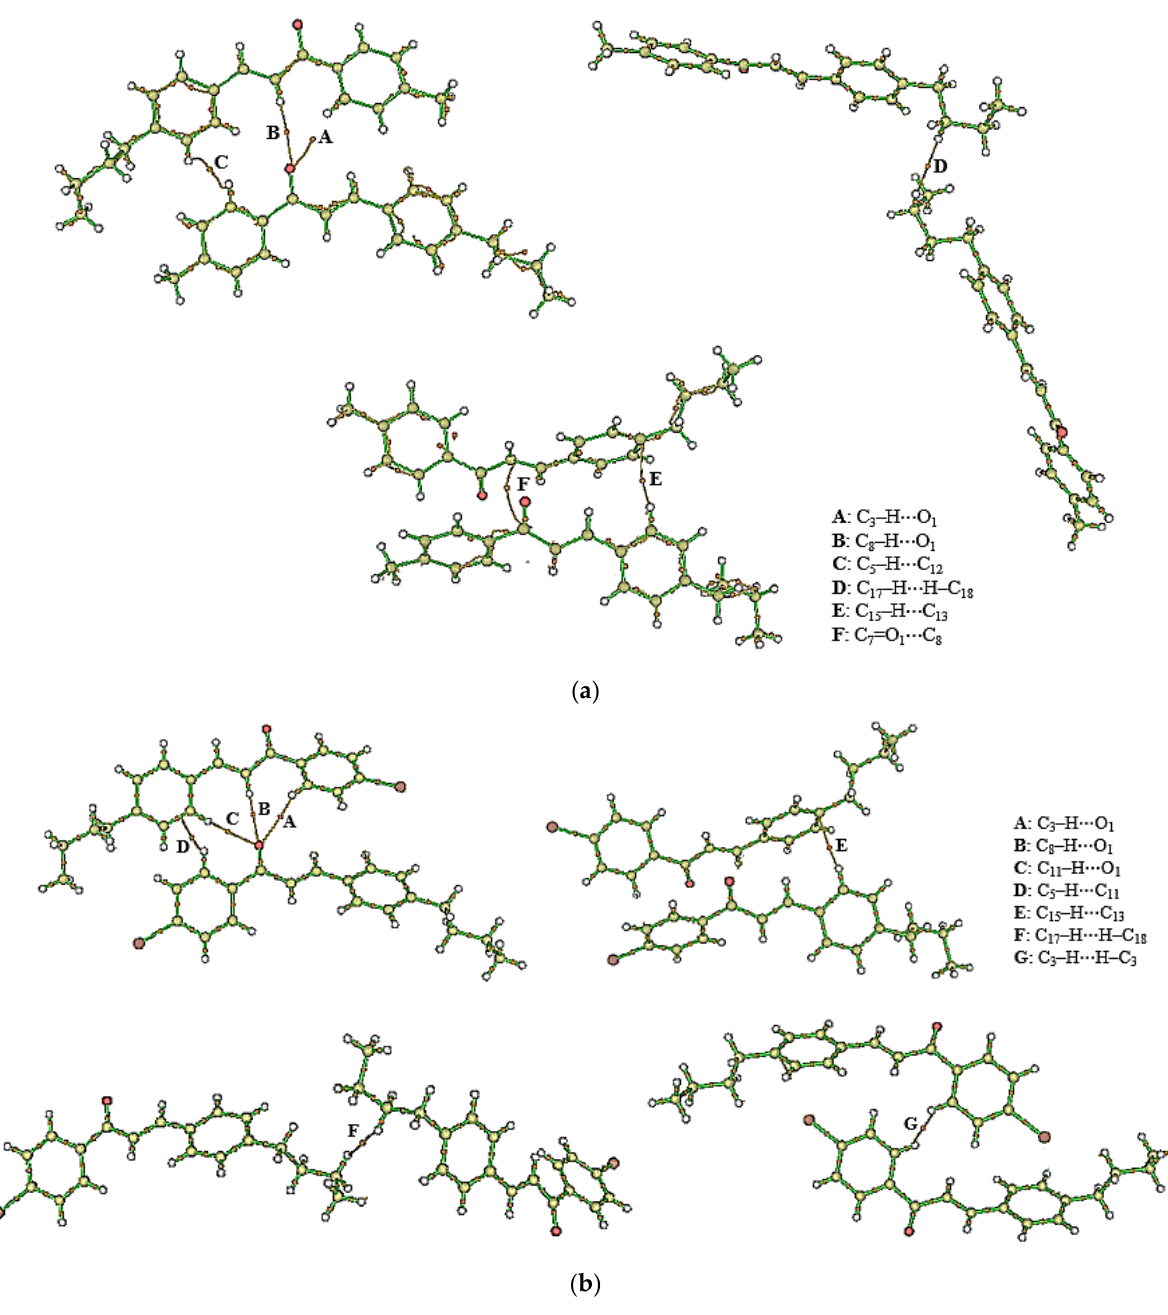
Figure 12. Molecular graphs of some bond paths of the intermolecular interactions in the supramolecular arrangements of the ( a ) BMP and ( b ) BBP chalcones.